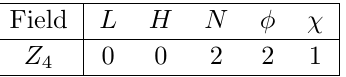
Table 1 . Transformation properties (cid:12)elds involved under Z 4 in additive notation where charge q means: the (cid:12)eld transforms like e i 2 (cid:25)q= 4